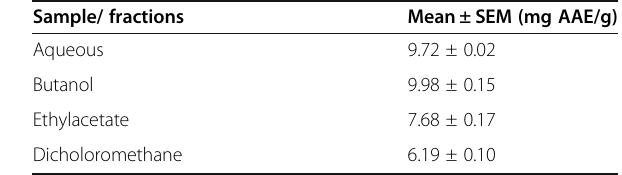
Table 6 Total antioxidant capacity (TAC) activities of different solvent fractions of P.